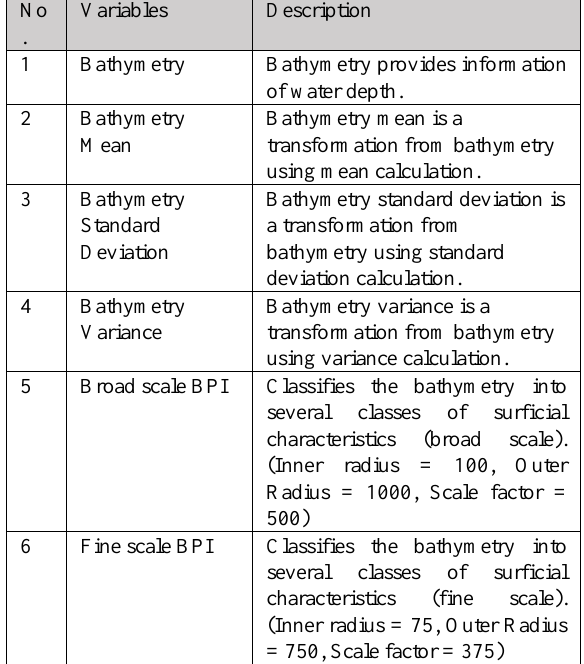
bootstrap procedures for the final models. Each of the replicates used a randomly selected seagrass presence-only data. The seagrass presence-only data were separated into training data and test data (75% and 25% of the data, respectively) (Briscoe et al., 2014; Wang et al., 2017). A set of seagrass occurrence data that contained five (5) drop locations within the surveyed area was used. The MaxEnt model was validated using test dataset consisting of one (1) presence data for test set. The output format is logistic, as this format can be portrayed in logistic habitat suitability index ranging from the lowest “0” to the highest